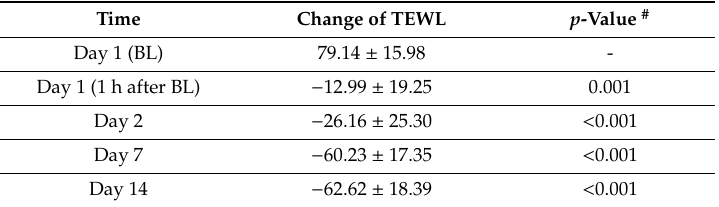
Table 1. Mean change from baseline in transepidermal water loss (TEWL) following application of 5%